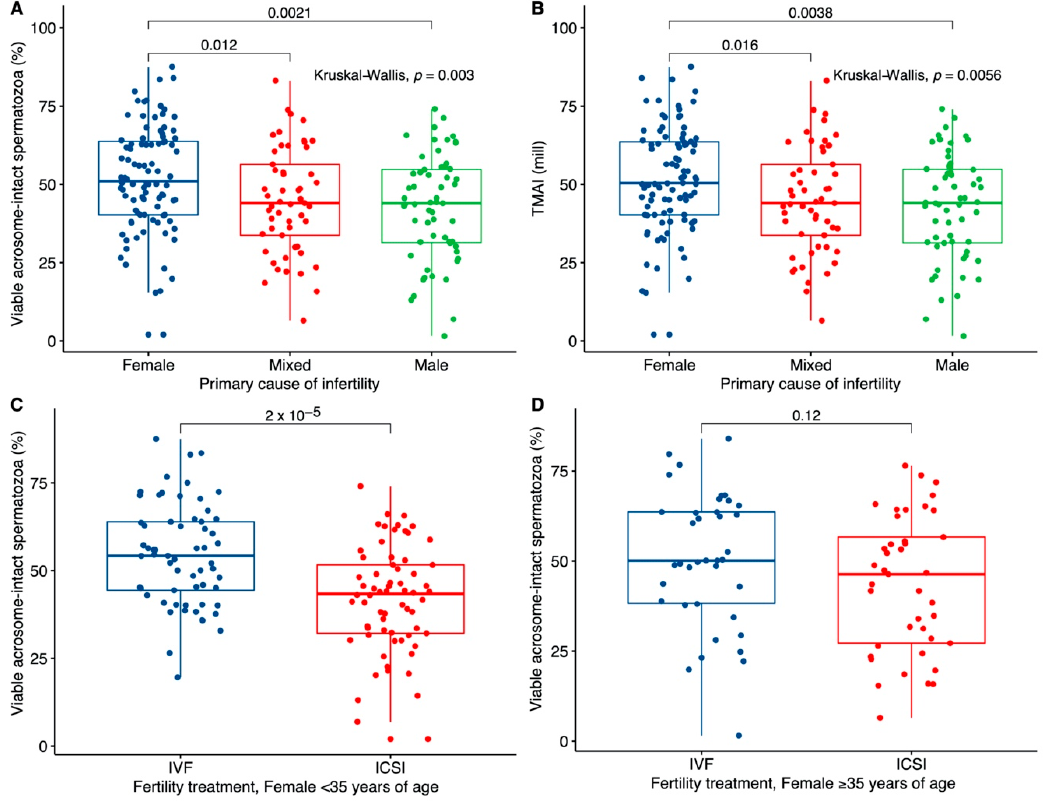
Figure 2. Acrosomal status in relation to the primary cause of infertility and female age. Couples going through fertility treatment were grouped into female, male or mixed causes of infertility. ( A ) Percentage of viable acrosome-intact spermatozoa in fresh purified semen samples versus the primary cause of infertility. ( B ) The total number of progressive motile spermatozoa with intact acrosomes (TMAI) in fresh purified semen samples versus the primary cause of infertility (female causes (blue) n = 92, mixed causes (red) n = 53, male causes (green) n = 59). Percentage of viable acrosome-intact spermatozoa in fresh purified semen samples versus ( C ) the type of fertility treatment for couples with women <35 years of age (IVF (blue): n = 61; ICSI (red) n = 66) and ( D ) the type of fertility treatment for couples with women ≥ 35 years of age (IVF (blue) n = 38, ICSI (red) n = 41). The boxplots depict the median and interquartile ranges, and the whiskers mark 1.5x the interquartile range .